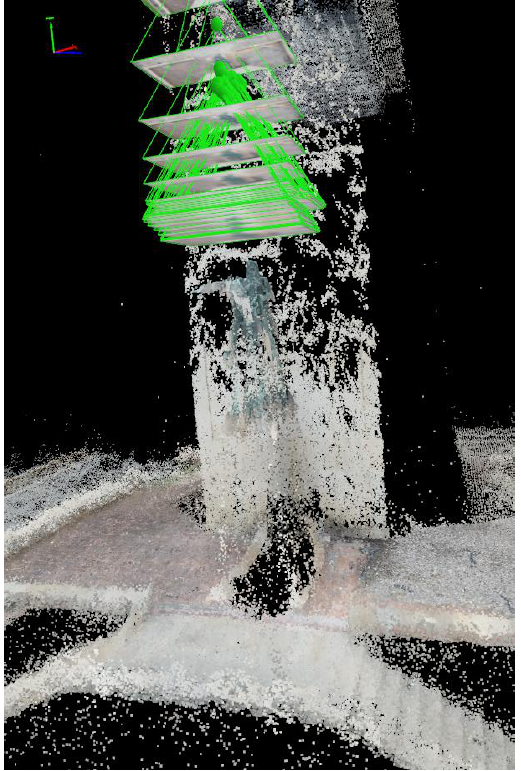
Figure 8: Monument points cloud with processing